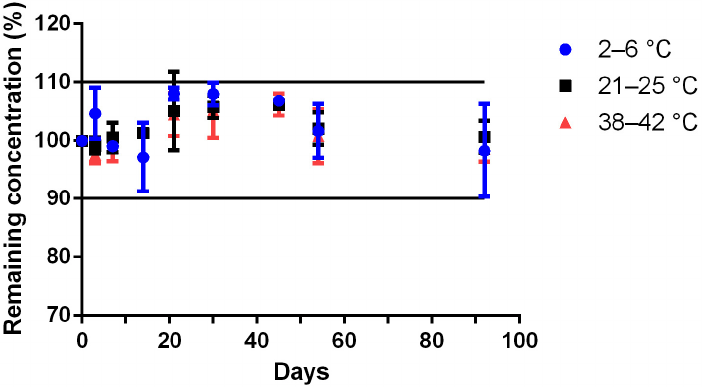
Figure 4. Stability over time of methionine formulated powder at 4 ± 2 ◦ C (blue circle), 23 ± 2 ◦ C (black square), 40 ± 2 ◦ C (red triangle) in glass pharmaceutical bottles and over time. Remaining methionine concentration, calculated by the ratio of the concentration on the tested day to the concentration at day 0; values are mean ± SD ( n = 3).